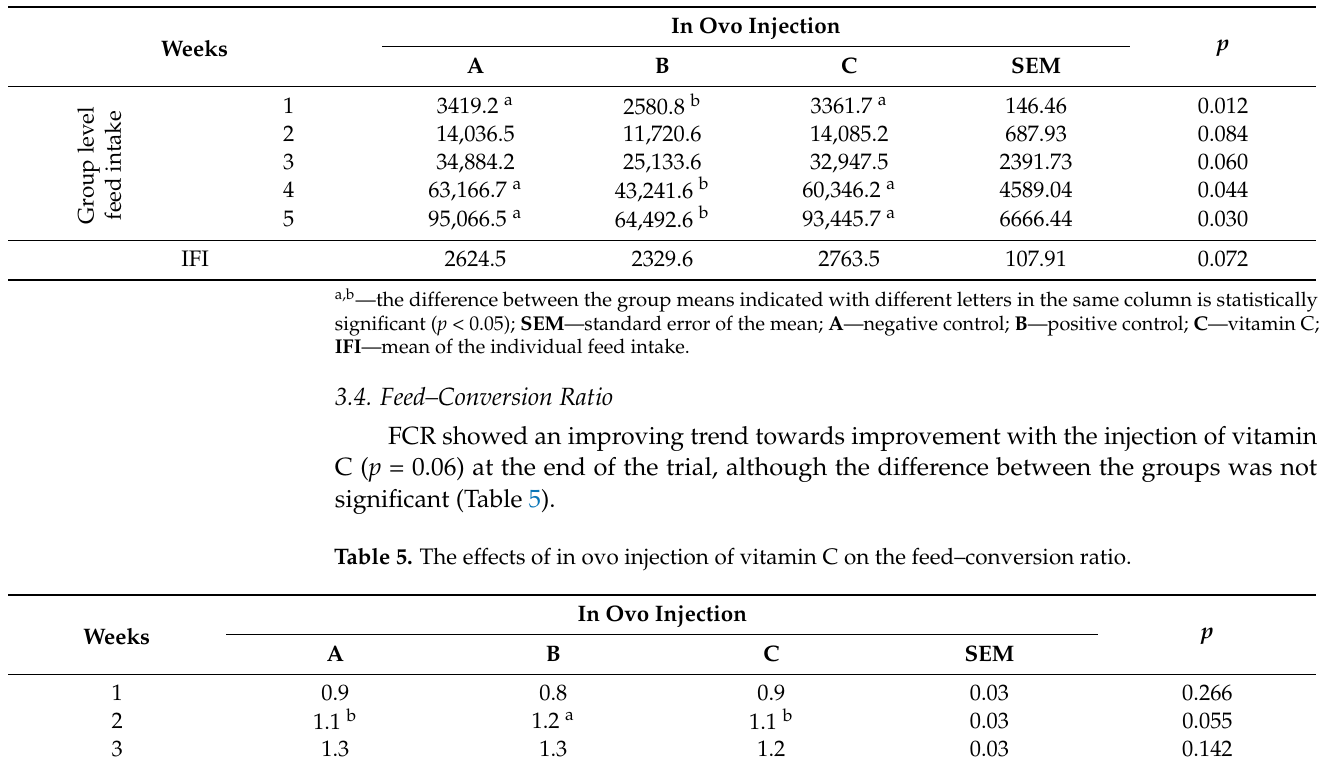
Table 4. The effects of in ovo injection of vitamin C on feed intake (g).